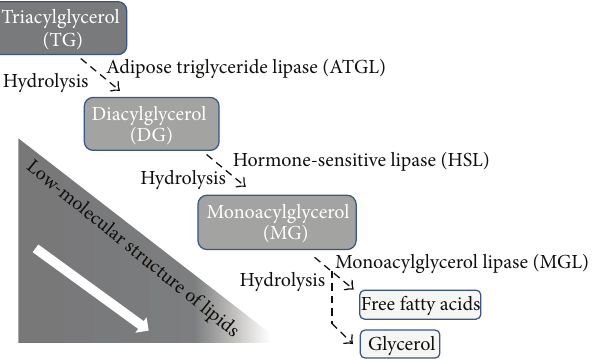
Figure 2: ATGL acts exclusively on the hydrolysis of TG. A major component of HSL activity depends on the generation of DG, a substrate from the action of ATGL. Finally, MGL acts to liberate glycerol and the final FFA. regulation of enzyme activity and is closely associated with the catabolism of